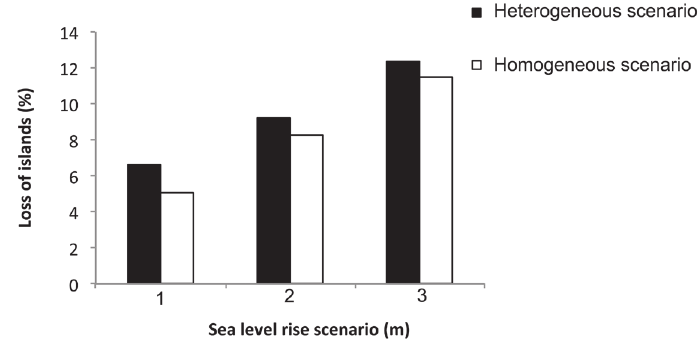
Figure 1. Percentage of islands entirely submerged under three scenarios (lower ≈1 m, middle ≈2 m and upper ≈3 meters) and two projections (homogeneous rise and heterogeneous rise).